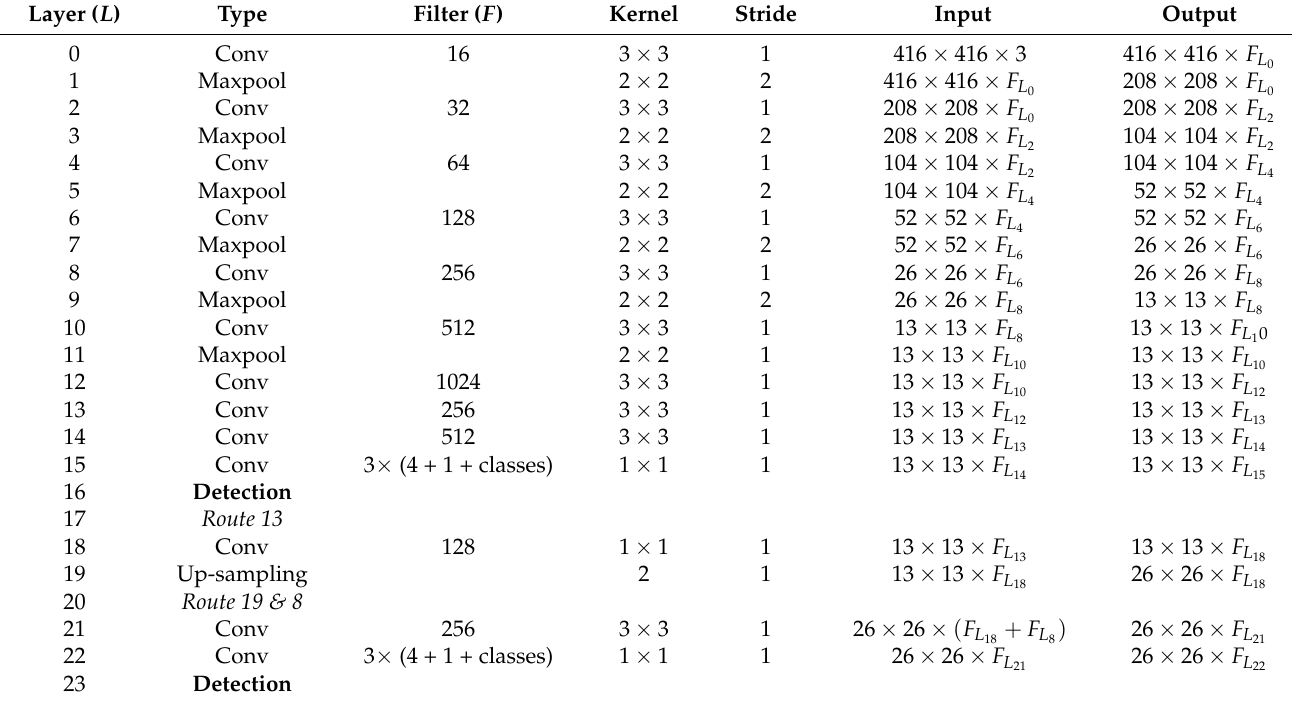
Table 2. YOLOv3-tiny network structure which uses Darknet19 as the backbone network and 2-scale prediction. Layer ( L ) Type